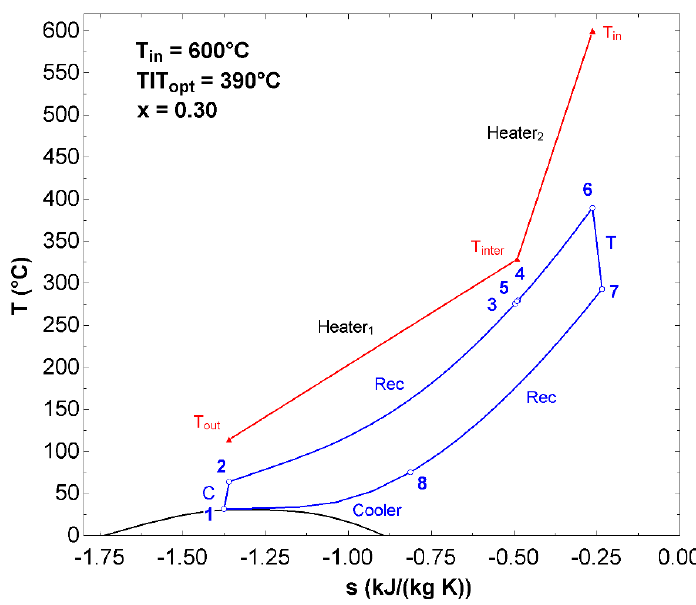
Figure 11. Partial heating layout: T–s diagram of the optimum thermodynamic cycle maximizing η TOT . The cooling profile of the heat source is superimposed.